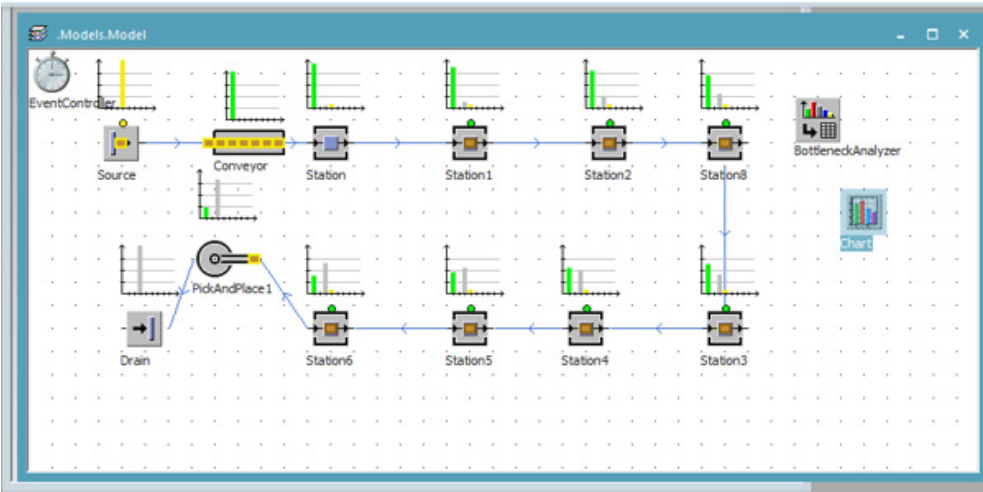
Figure 5. Simulation model 2D: A intermediate sequence.